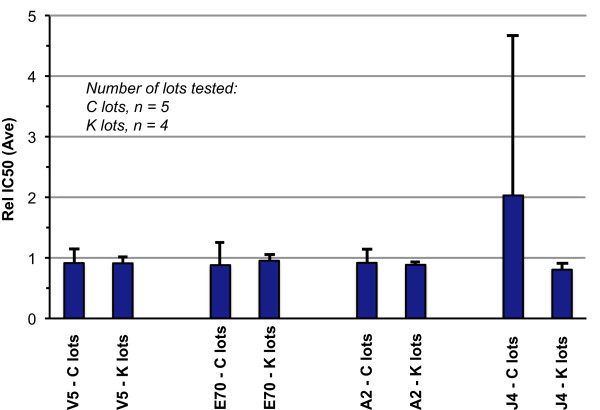
Consistency in epitope specific antigenicity for clinical stage developmental lots ("C" lots) and commercial lots ("K" lots) as probed with a panel of mAbs. Four mAbs were employed to track the solution antigenicity of the various lots (see relative IC50 values in Table 2) to provide additional quantitative information on VLP epitopes, in addition to product release tests. The one standard deviations were plotted for clinical lots (n = 5) and for commercial lots (n = 4) to illustrate the tighter range of VLP solution antigenicity of commercial lots achieved as compared to clinical developmental lots.